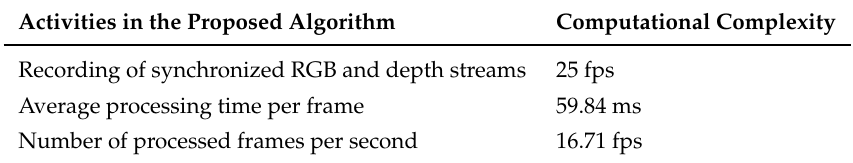
Table 3. Computational complexity of the proposed